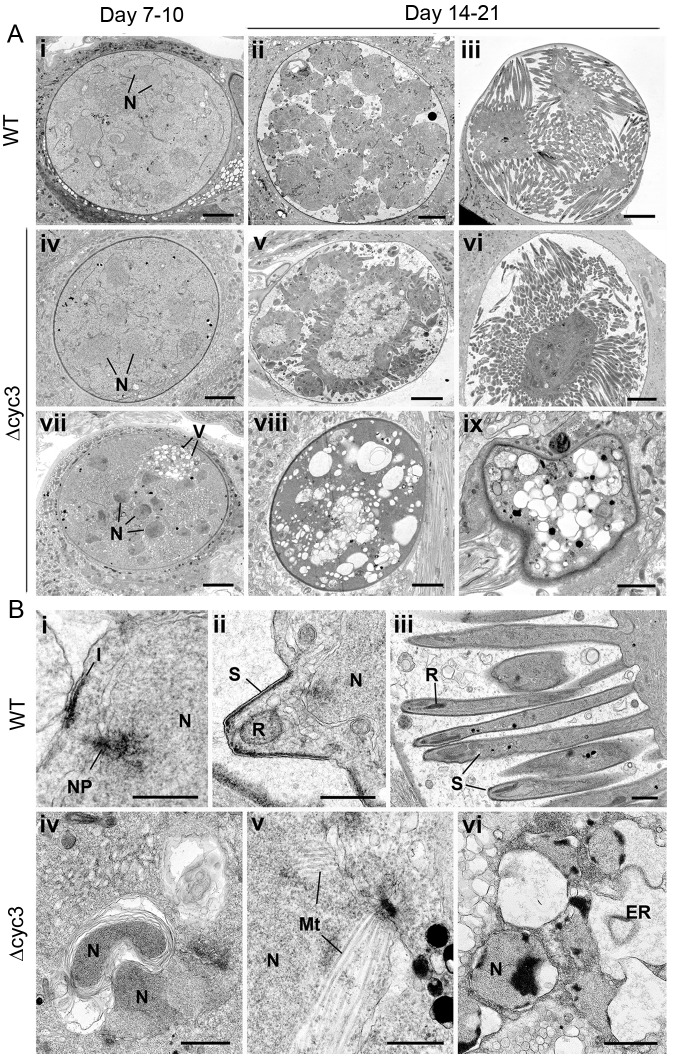
Ultrastructure analysis of oocyst development in ∆cyc3 mutant.(A) Low power ultrastructural images of oocyst development at 7–10 days (i, iv, vii) and 14–21 days post-infection (dpi) showing normal sporulation of WT (ii, iii) and certain Δcyc3 (v, vi) parasites while other Δcyc3 mutants show evidence of cytoplasmic vacuolation (V) and degeneration (vii, viii, ix). N–nucleus. Bars represent 10 μm. (B) Details showing progressive stages in sporozoite formation in wild type parasites (i-iii) and various abnormal developmental stages of the Δcyc3 parasite (iv-vi). Bars represent 1 μm. i. Initiation of sporozoite formation with formation of the inner membrane complex (I) beneath the plasmalemma and above a peripherally located nucleus (N) with nuclear pole (NP). ii. Early sporozoite (S) with rhoptry anlagen (R) budding from the surface of the sporoblast. N–nucleus. iii. Late stage in sporozoite formation showing the elongated sporozoites (S). R–rhoptry. iv. Detail of the sporoblast cytoplasm showing nuclei (N) enclosed by abnormal membrane whorls v. Part of a nucleus with extensive nuclear spindle microtubule (Mt) not seen in WT parasite. vi. Detail of a late stage in parasite degeneration showing apoptotic-like nuclei (N) and dilated endoplasmic reticulum (ER).